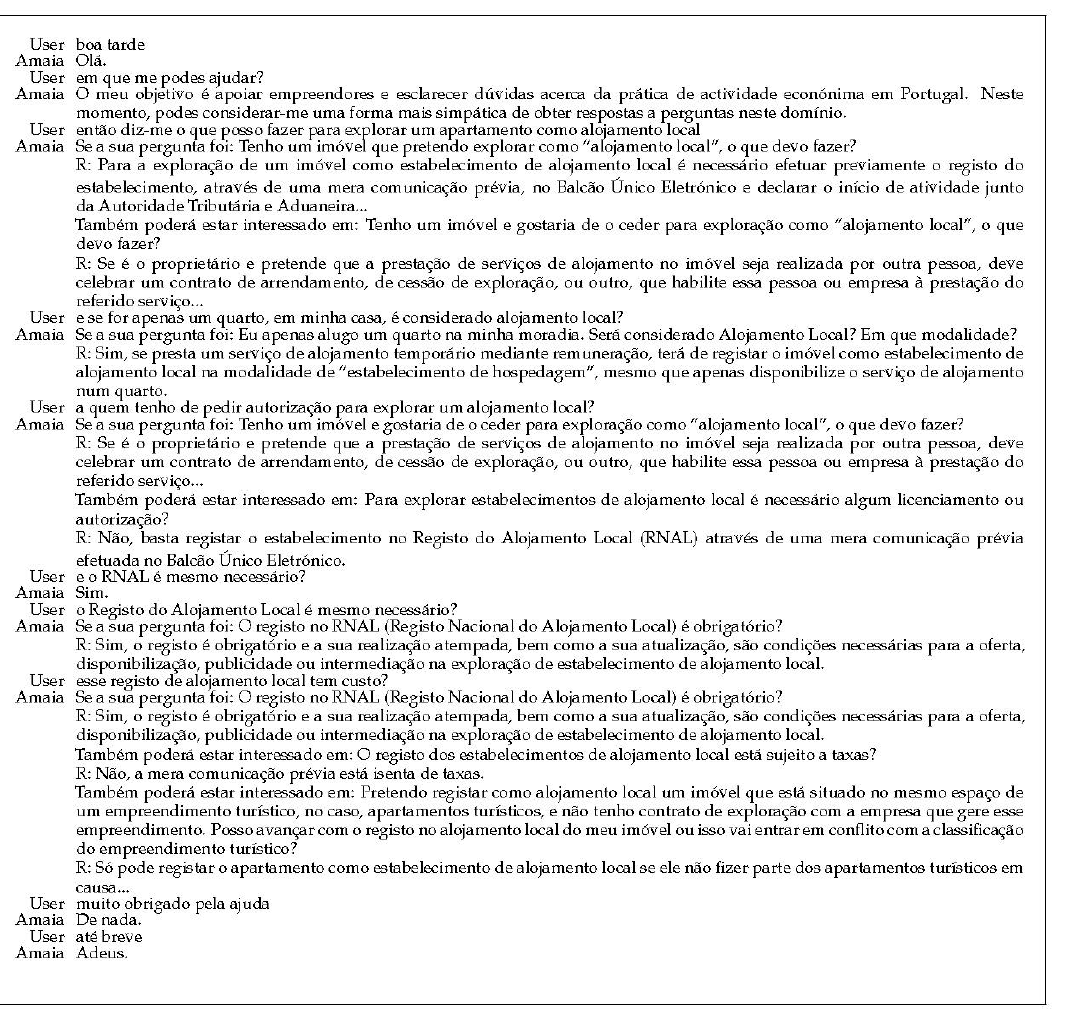
Figure 2. A conversation with